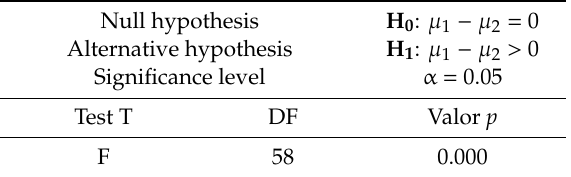
Table 12. Hypothesis Testing for Comparing Medians of two